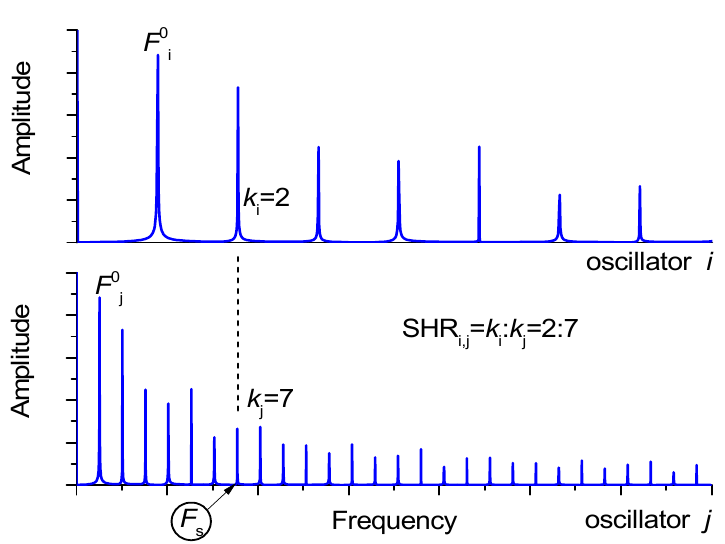
Figure 4. Qualitative spectra of two coupled synchronized oscillators with parameter SHR i,j = 2:7.